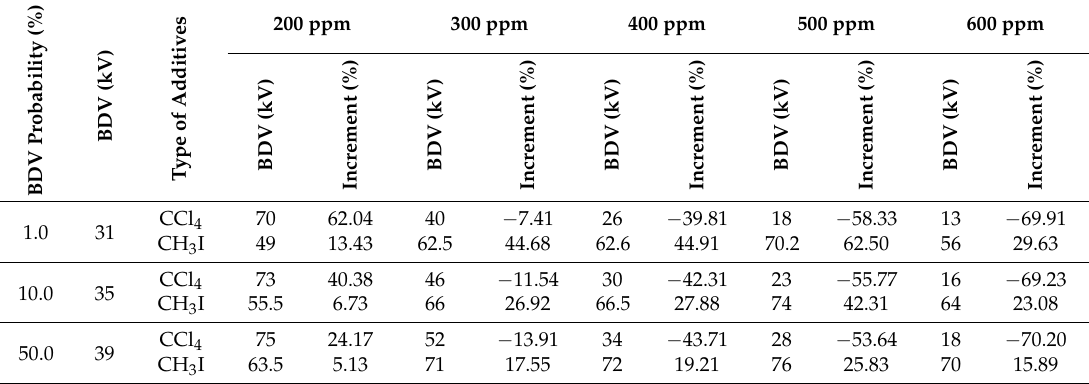
Table 4. The AC breakdown voltage at different breakdown probabilities for the mineral oil with CCl 4 and CH 3 I electronic scavenger additives at various concentrations in the mineral